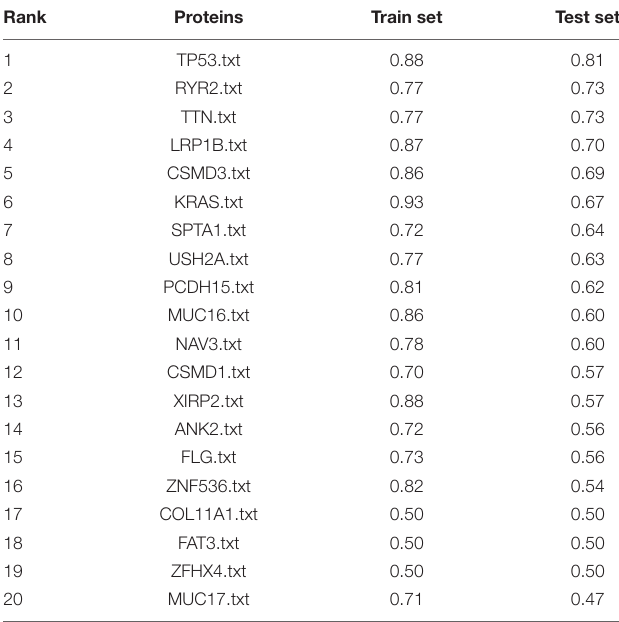
TABLE 5 | Top 20 AUC value of somatic mutations predicted by Elastic Net models.